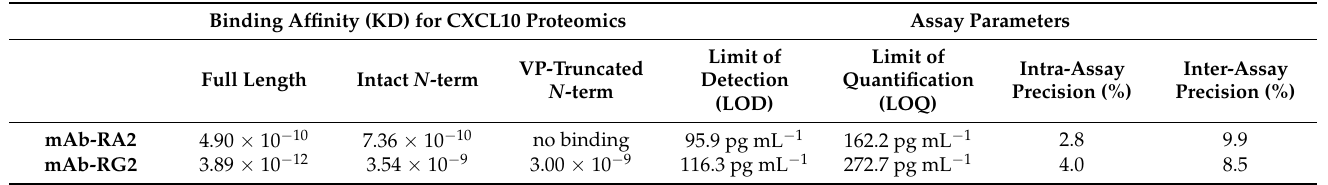
Table 1. Binding affinity and precision of mAb-RA2 and mAB-RG2.